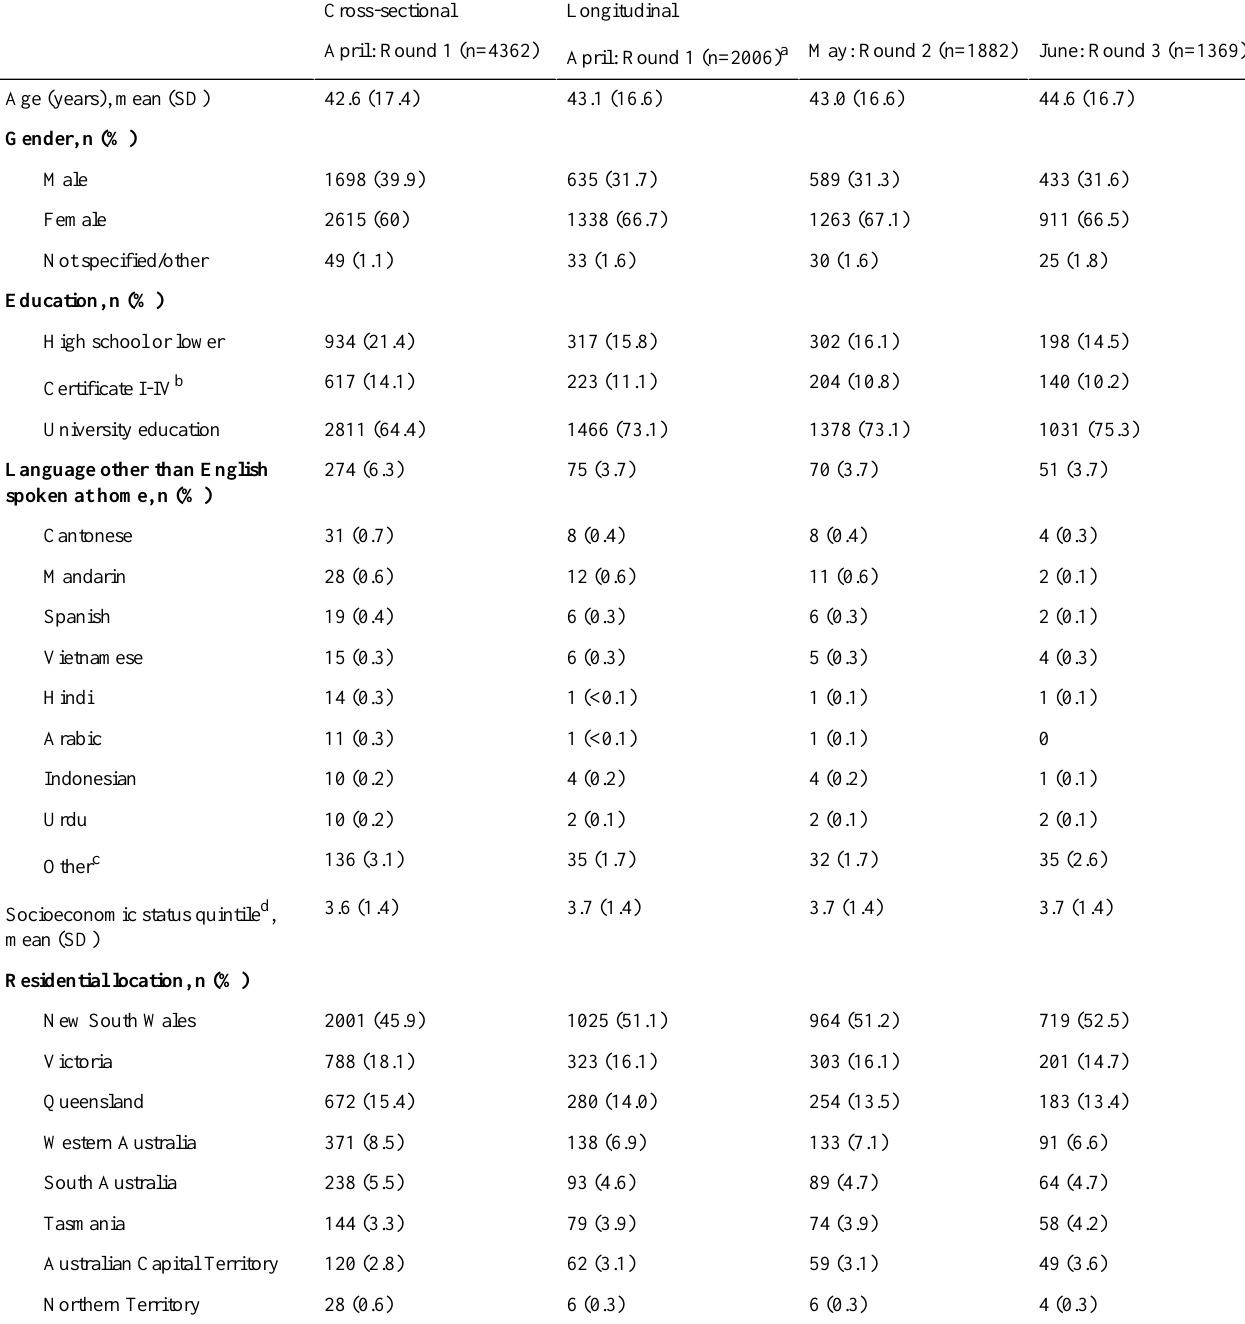
Table 2. Sample characteristics by study round